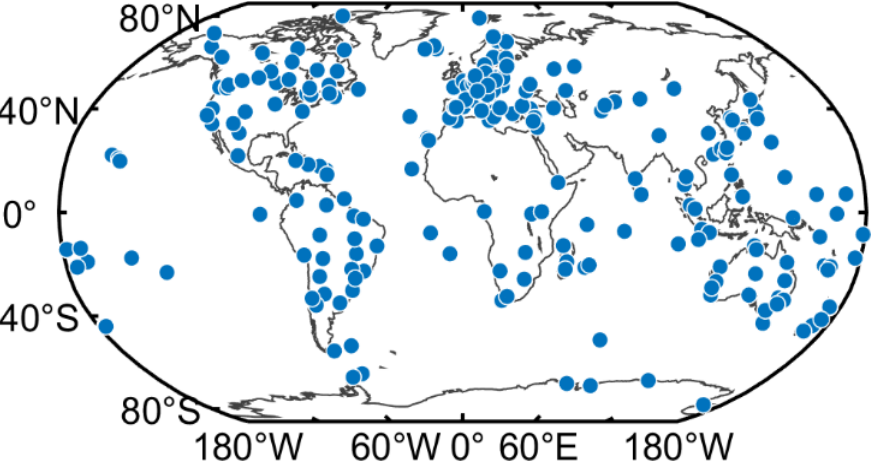
Figure 3. Distribution of the MGEX stations used in this study.